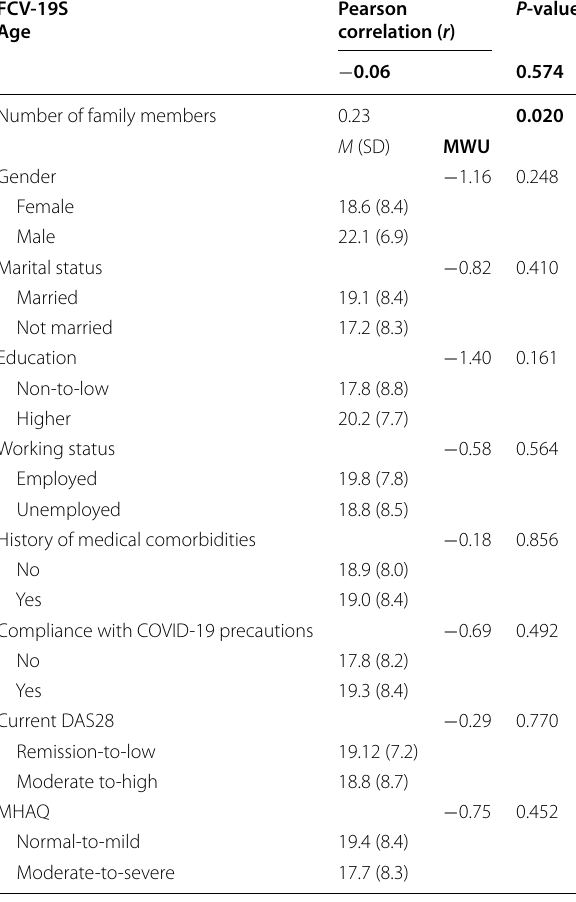
Table 3 Correlation between perceived fear of COVID-19 infection, and demographic, clinical, and COVID-19-related factors of patients with RA